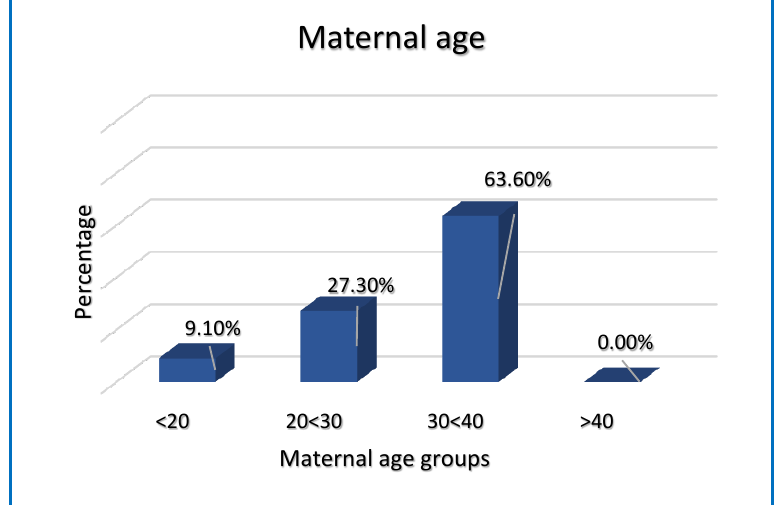
Figure 1. Maternal age and stillbirth.